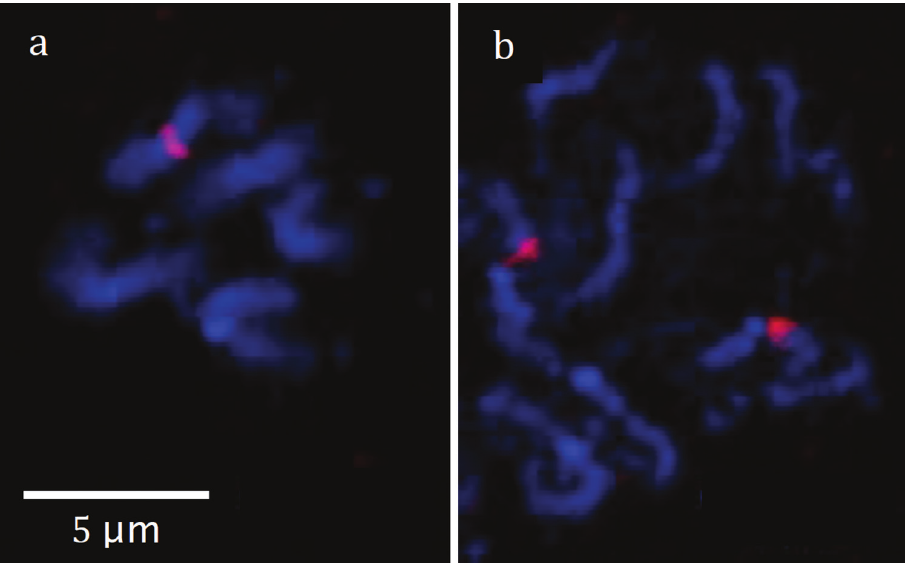
Figure 4. Fluorescence in situ hybridization with 28S rDNA probe. a metaphase chromosomes of the haploid karyotype and b prometaphase chromosomes of the diploid karyotype of A. coreae . Red = hy- bridization signal (a single rDNA cluster in the haploid set and paired clusters in the diploid set), blue = counterstaining of chromosomes with